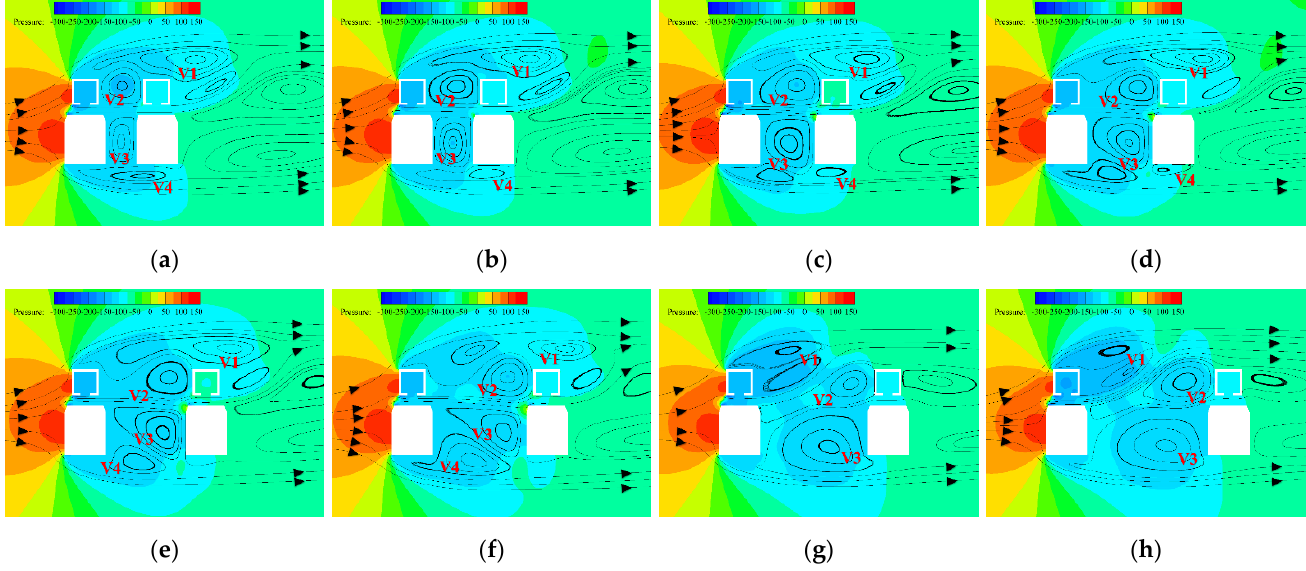
Figure 29. Flow line and pressure nephogram of the vehicle–bridge system investigated in Case 4: ( a ) D/B = 1.66; ( b ) D/B = 2.00; ( c ) D/B = 2.54; ( d ) D/B = 3.00; ( e ) D/B = 3.50; ( f ) D/B = 4.00; ( g ) D/B = 4.50; ( h ) D/B = 5.00. (units: Pa).